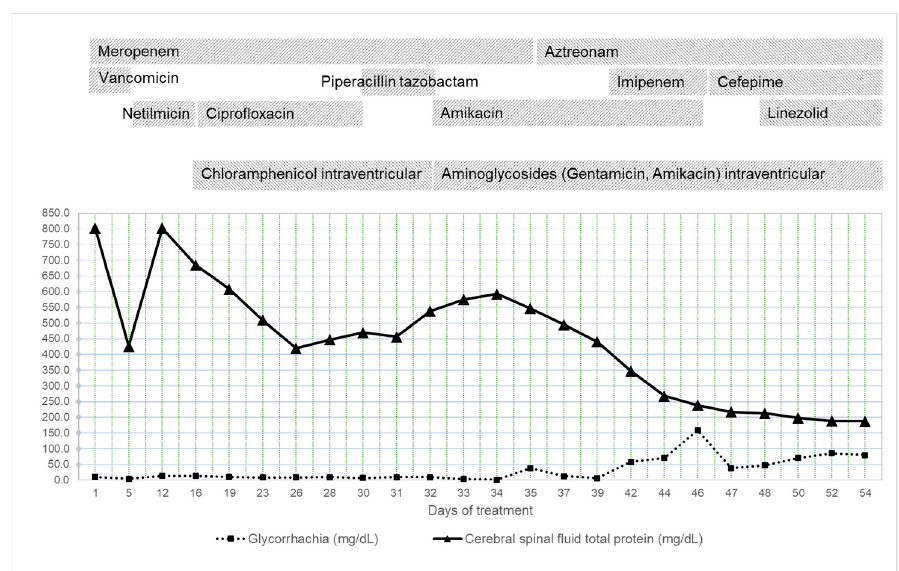
Figure 6. Evolution of glycorrhachia and total protein in cerebral spinal fl uid during hospitaliza- tion.